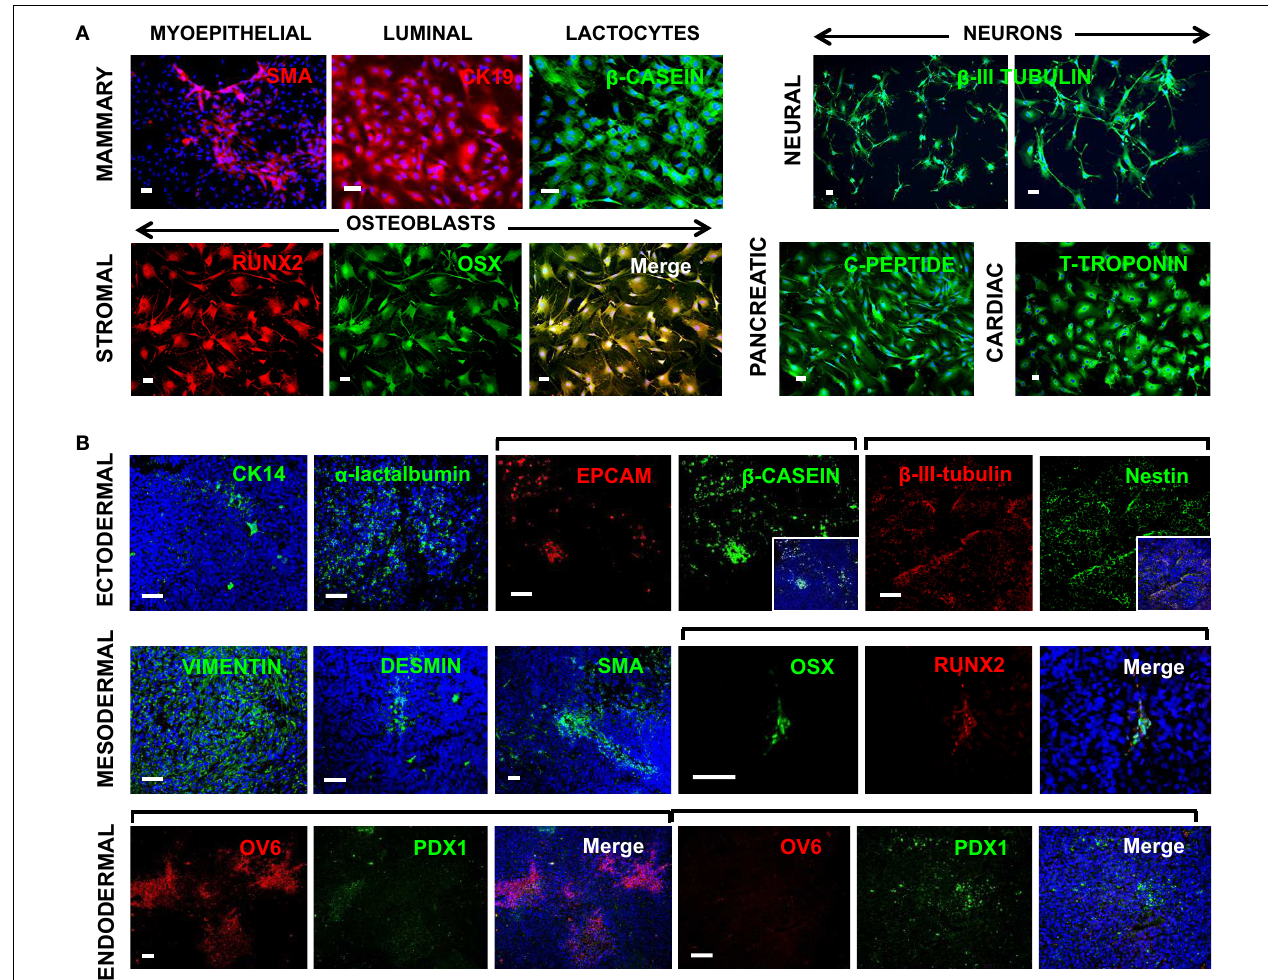
osteoblast-like cells, c-peptide + islet-like cells, andT-troponin + cardiomyocyte-like cells. (B) Tumors formed in nude/SCID mice by OTBCs contained cells from all three germ layers. Blue: DAPI nuclear stain. Scale bars: 50 µ